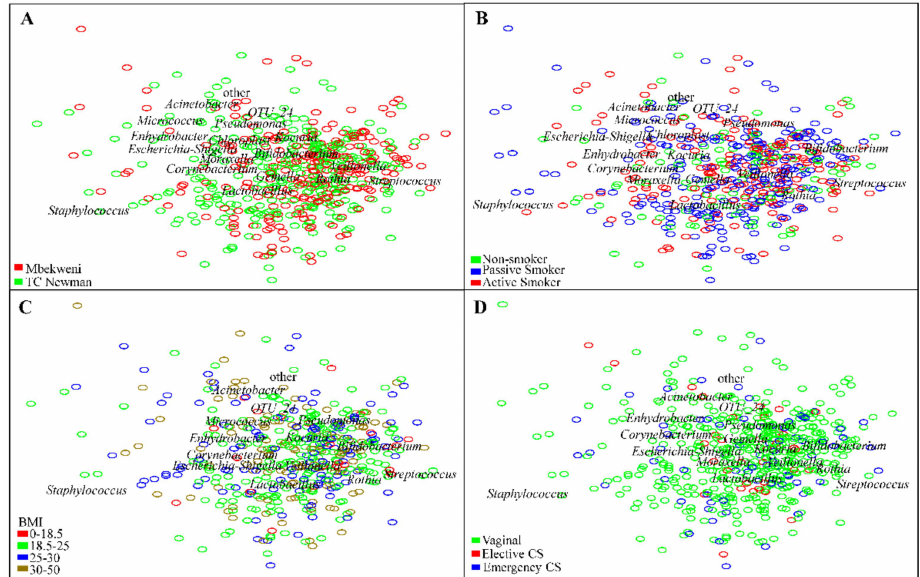
Figure 6. Log–ratio biplot of human breast milk bacterial abundances at the genus level. Samples are colored according to ( A ) study site, ( B ) maternal smoking, ( C ) body mass index (BMI), and ( D ) delivery mode. Each sample is represented by a circle and is colored based on group type. Samples (circles) that cluster together are similar in bacterial composition and